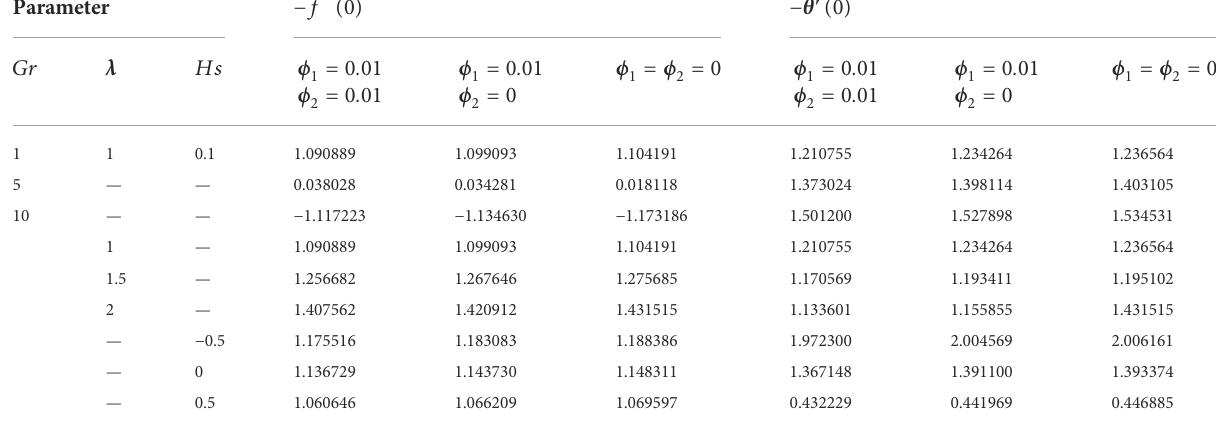
TABLE 5 Change in f 99 ( 0 ) & θ 9 ( 0 ) for various parameters in the plate when Sc (cid:3) 0 . 8 , Kc (cid:3) Ks (cid:3) 0 . 1.